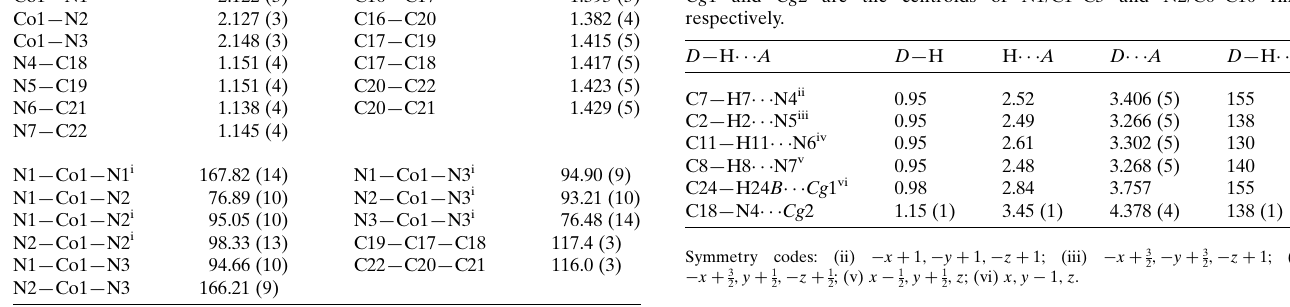
Table 2 Hydrogen-bond geometry (A˚ , (cid:4) ).